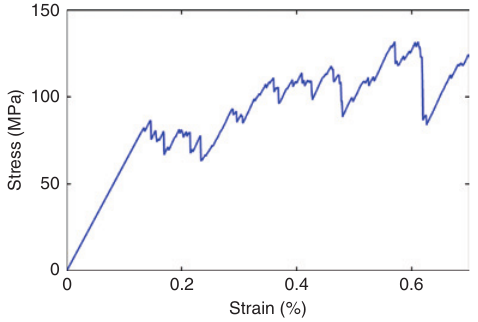
Figure 5: A stress-strain curve calculated from the uncorrelated stochastic